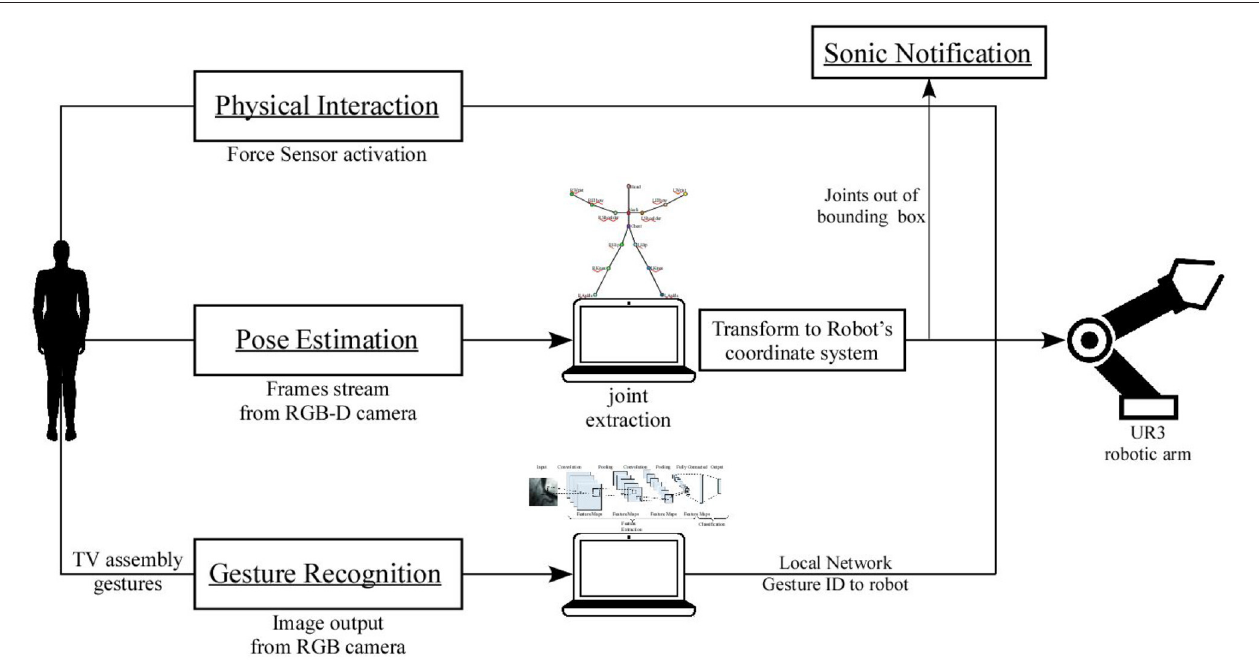
FIGURE 2 | Architecture of the